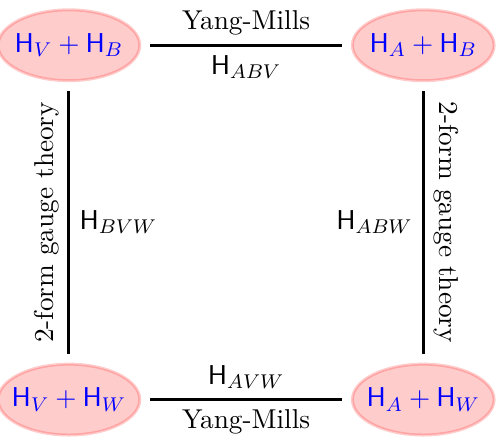
Figure 18 . A diagram representing four possible models with hamiltonians consisting of three out of four